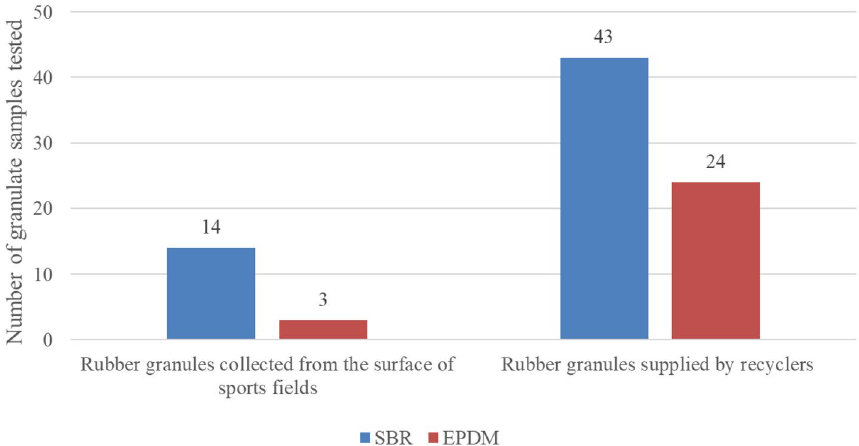
Figure 1. Number of samples of the tested SBR and EPDM granules in relation to their sources of origin.